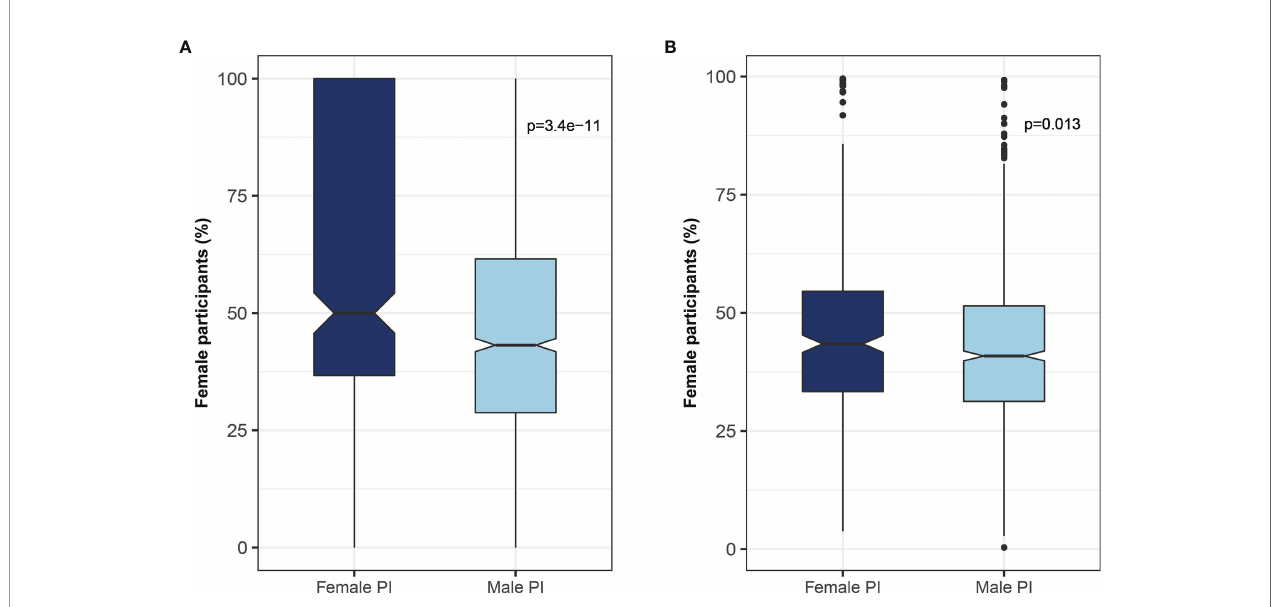
FIGURE 6 | Relationship between the gender of the investigator and trial participants. The association between the gender of the lead investigator and the proportion of female participants enrolled in the trial for (A) all studies, and (B) studies excluding gender-speci fi c malignancies (e.g., uterine, ovary, and